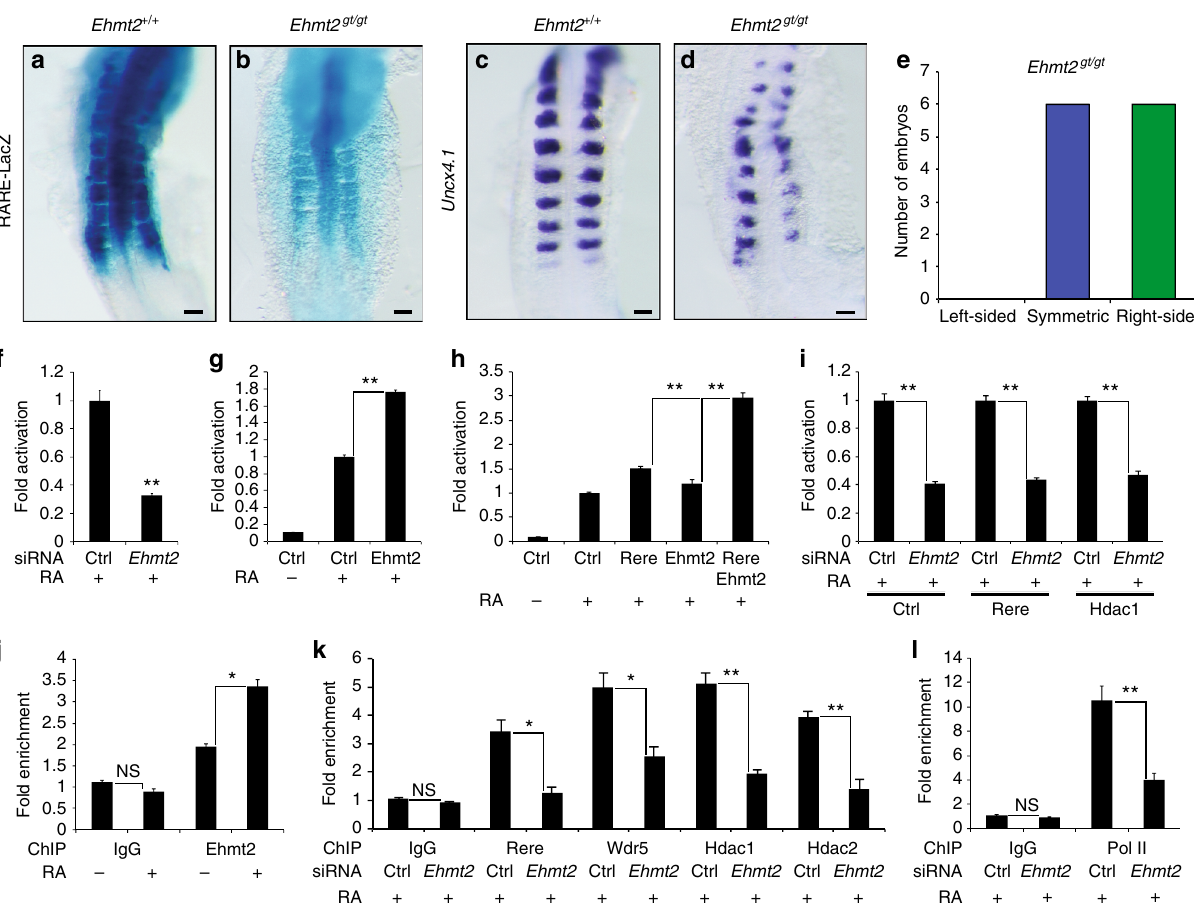
Fig. 5 Ehmt2 controls retinoic acid signaling and symmetric somite formation. a , b RARE-LacZ activity in control Ehmt2 + / + a and Ehmt2 gt/gt b embryos at E8.75- E9.0 ( dorsal views ). c , d In situ hybridization for Uncx4.1 in wild-type Ehmt2 + / + c and Ehmt2 gt/gt d embryos at E8.75-E9.0 ( dorsal views ). e Graph representing the number of 7- somite to 15-somite stage Ehmt2 gt/gt embryos with left-sided ( orange ), symmetric ( blue ), or right-sided ( green ) delay in somite formation. f – i RARE-Luciferase activity from NIH3T3 cells treated with or without 1 µ M RA for 20h. f Cells treated with siRNA for Ehmt2 ( n = 4). g Cells transfected with an Ehmt2 expression plasmid ( n = 4). h Cells co-transfected with Rere and Ehmt2 expression plasmids ( n = 4). i Cells overexpressing Rere or Hdac1 and treated with siRNA against Ehmt2 ( n = 4). j ChIP of the Rar β promoter with a speci fi c antibody for Ehmt2 using NIH3T3 cells treated or not with 1 µ M RA during 1h ( n = 3). k , l ChIP analysis of the Rar β promoter in NIH3T3 cells transfected with siRNA for Ehmt2 and treated with 1 µ M RA during 1h. ChIP was performed with antibodies speci fi c to Rere, Wdr5, Hdac1, and Hdac2 k or Pol II l ( n = 3). In all graphs data represent mean ± s.e.m. NS — not signi fi cant, * P < 0.05 and ** P <